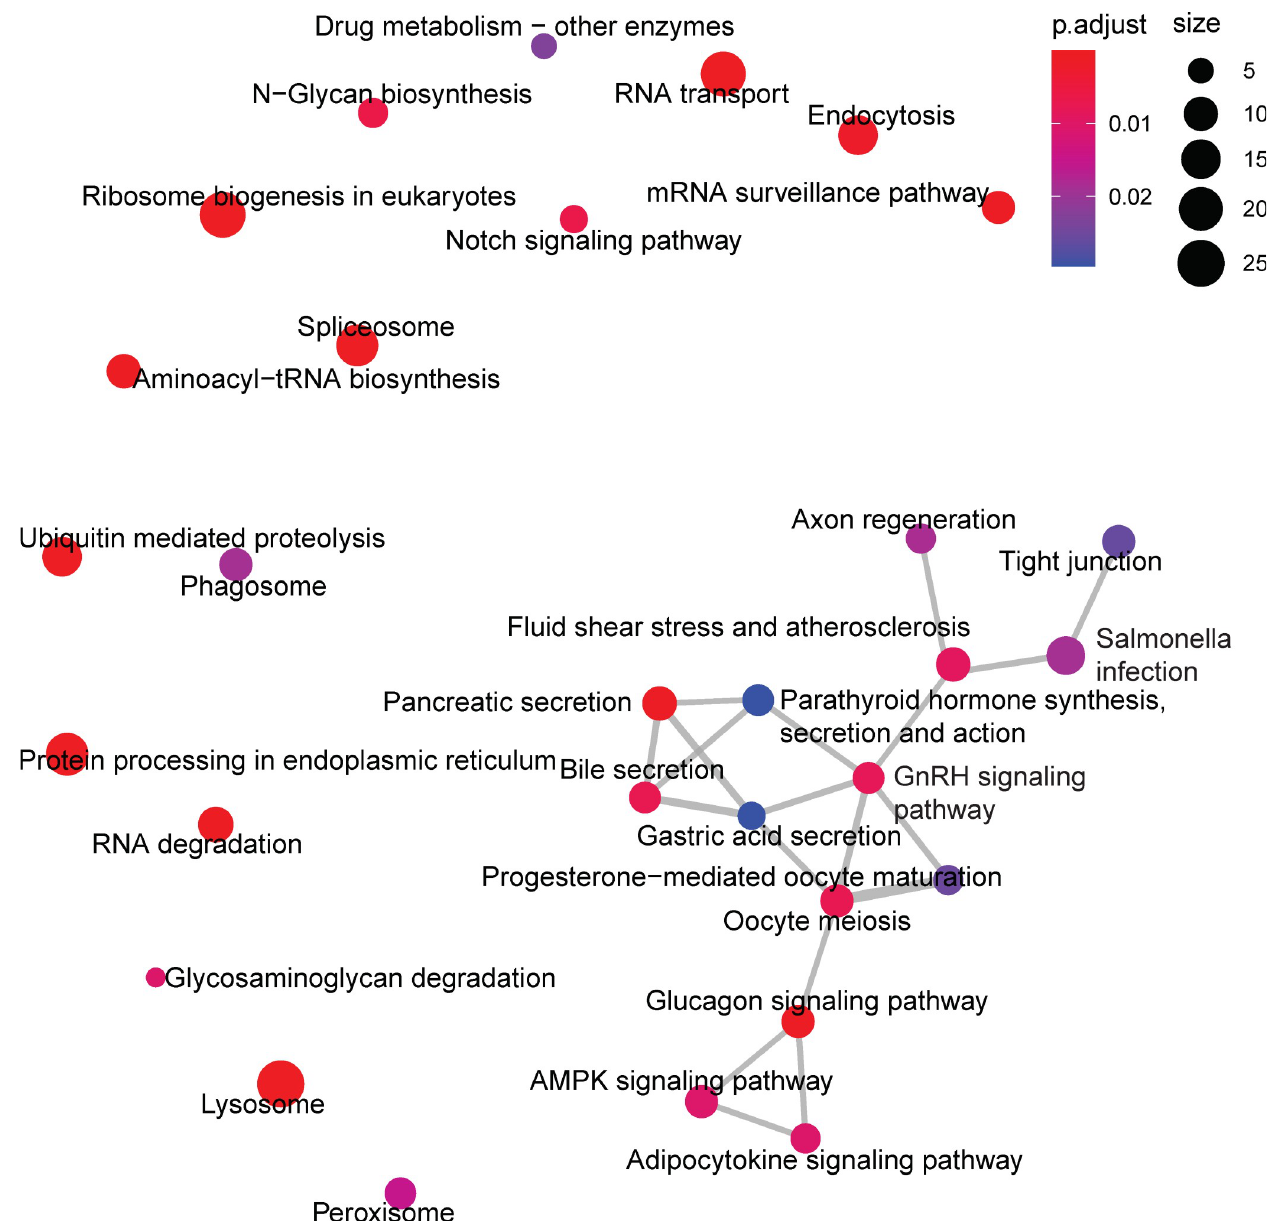
Fig 5. Enrichment map of Kyoto Encyclopedia of Genes and Genomes (KEGG) pathways for the pink consensus co-expression module. Symbol explanation as in Fig 4. The Protein processing in the endoplasmic reticulum , Lysosome , and Ribosome biogenesis in eukaryotes pathways are among the largest and most significantly enriched pathways. This module was positively correlated with age, suggesting these pathways are upregulated in aging. Of the transcripts in the greenyellow , darkgreen , and pink modules, 17, 7, and 8 respectively exhibited a module membership greater than 0.8 for their respective modules and mapped to a C . gigas gene with a log 2 fold change of greater than or equal to 1 in response to immune priming and/or viral challenge in Lafont et al (2020) [37] (Table 8). Of those, transcripts from the greenyellow and darkgreen modules mapped primarily to C . gigas genes with putative viral function. Furthermore, the greenyellow transcripts mapped to C. gigas genes assigned by